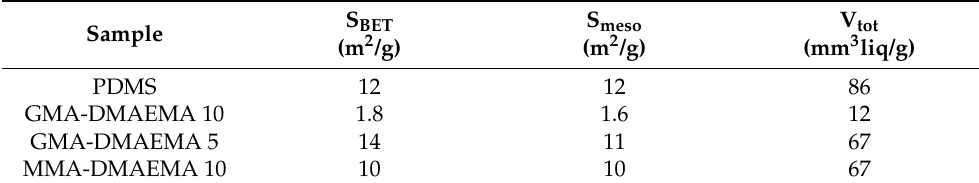
Table 3. Specific surface characterization results of all tested